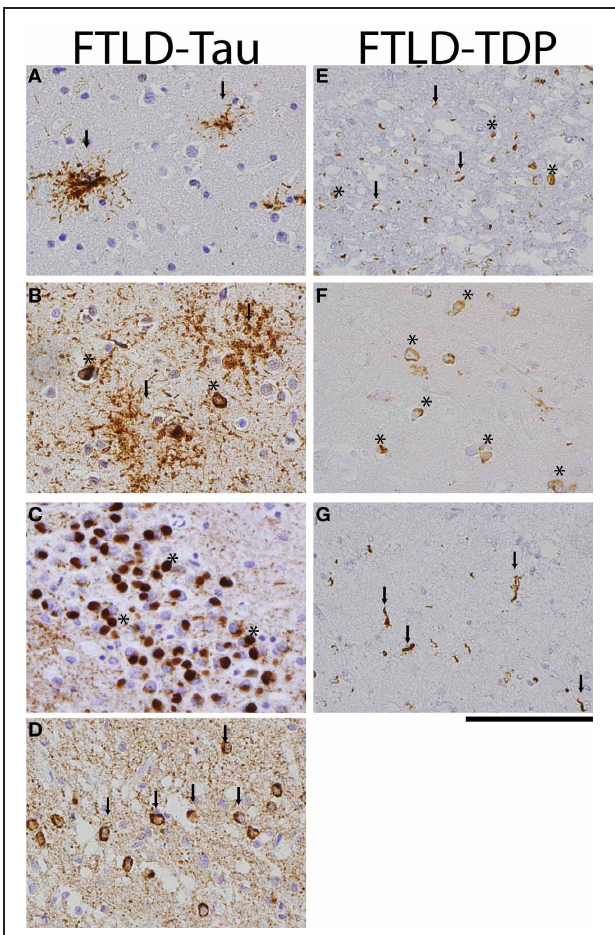
FIGURE 2 | FTLD-Tau and FTLD-TDP histology. Photomicrographs of FTLD-tau (A–D) and FTLD-TDP (E–G) visualized with immunohistochemistry (PHF-1 and pTDP 409/410 for tau and TDP, respectively). (A) PSP frontal cortex with tau-positive tufted astrocytes (arrows), (B) CBD temporal cortex with diffuse astrocytic plaques (arrows) and neuronal tangles (asterisks), (C) Pick’s disease with round tau-positive Pick bodies (asterisks) in the dentate nucleus of the hippocampus, (D) FTDP-17 case with p.P301L pathogenic mutation with tau-positive neuronal tangles (arrows) and diffuse neuropil threads in temporal cortex, (E) FTLD-TDP subtype A with cytoplasmic neuronal inclusions (asterisks) and short dystrophic neurites (arrows) in superficial layers of frontal cortex, (F) FTLD-TDP subtype B with prominent cytoplasmic inclusions (asterisks) in deep temporal cortical layer, and (G) long dystrophic neurites (arrows) in superficial layers of mid-frontal cortex of a patient with FTLD-TDP subtype C. Scale bar = 100 μ